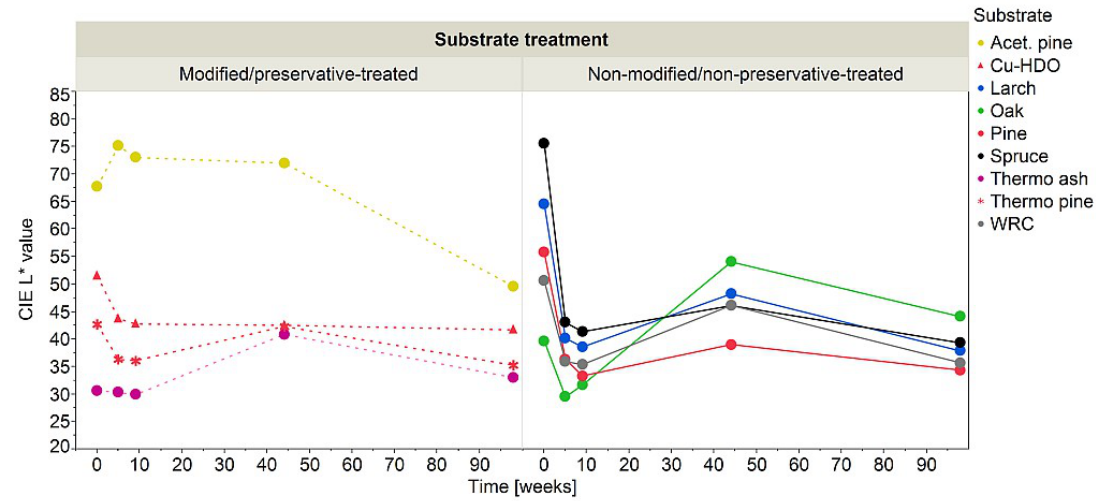
Figure 9. Mean L-values of the di ff erent substrates of sample set 3 treated with iron (II) sulfate before exposure and after 5, 9, 44, and 98 weeks of exposure at 45 ◦ to the south. Iron (II) sulfate’s staining e ff ect in terms of artificial graying is characterized by an immediate decrease in lightness after exposure.